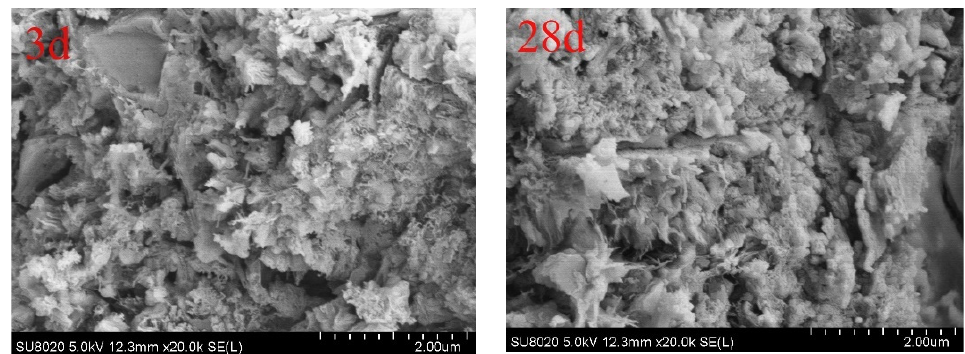
Figure 9. Results of the cement sample SEM for different ages.